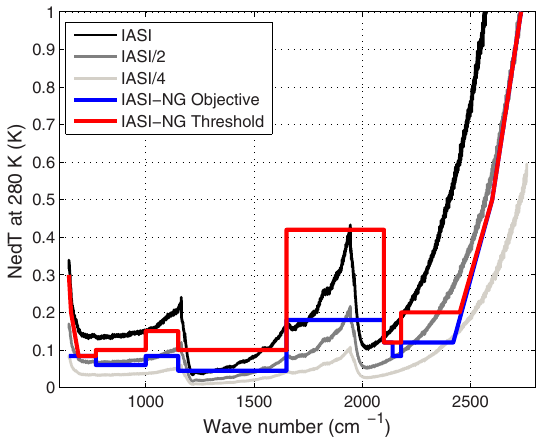
Figure 1. Radiometric noise expressed as level1c equivalent noise temperature Ne (cid:49)T for a reference temperature of 280K. The black line gives the in-flight measured IASI noise. Grey lines give the IASI noise when divided by a factor of 2 and 4. The current noise specifications for IASI-NG are plotted in red (threshold specifica- tion) and in blue (objective